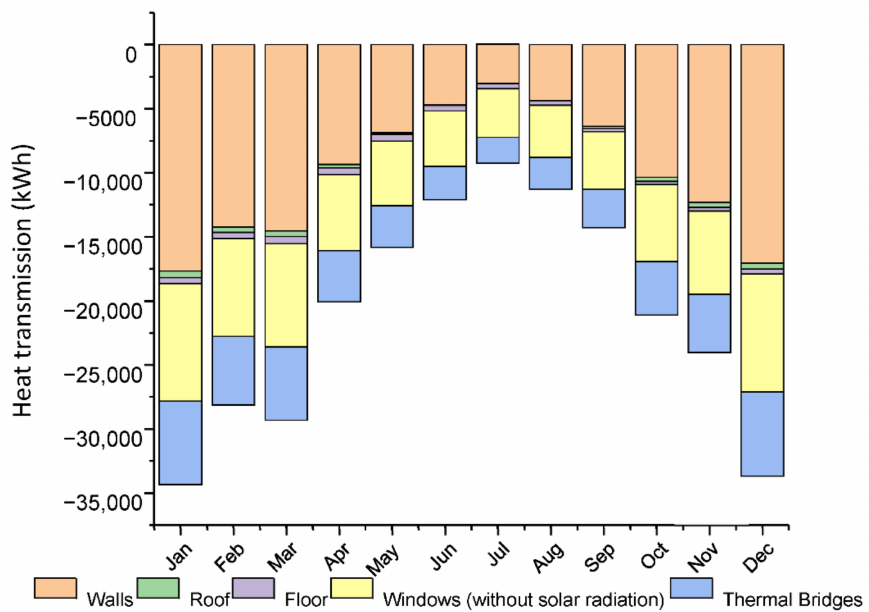
Figure 11. Monthly heat transmission (only sensible heat) through the envelope in case A (no low-E film).